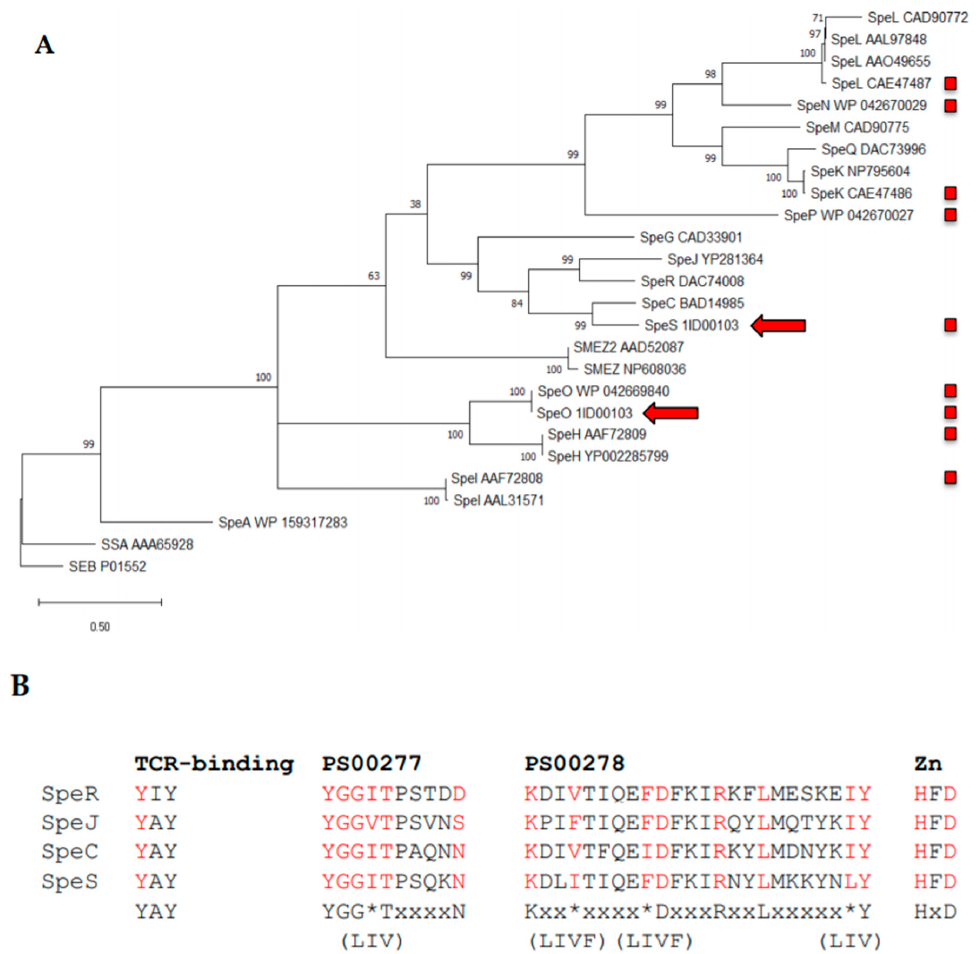
Figure 1. Similarity of the novel superantigen SpeS to known superantigens. ( A ) The amino acid sequences of representatives of the 16 known streptococcal superantigens, SpeS and the staphylococcal superantigen SEB were obtained. Nomenclature has been standardized in accordance with Commons et al., 2014 [13]. The signal sequences were identified using SignalP [21] and removed. The remaining predicted amino acid sequences were utilized to generate a maximum likelihood tree in MEGA X [22], which was rooted to SEB. The percentage of trees in which the associated taxa clustered together is shown next to the branches. The tree is drawn to scale, with branch lengths measured in the number of substitutions per site. The red arrows indicate the location of the SpeO and SpeS sequences encoded within the Sz 1ID00103 genome. Red boxes indicate superantigens encoded by S. equi or S. zooepidemicus . ( B ) Identification of signature domains found in superantigens. The amino acid sequence of SpeS was compared to the closest relatives SpeC, SpeJ and SpeR to identify motifs typically found in superantigens. The T cell receptor ß-binding motif YAY of SpeC [19,20], the consensus sequence Y-G-G-(LIV)-T-x 4 -N and K-x 2 -(LIVF)-x 4 -(LIVF)-D-x 3 -R-x 2 -L-x 5 -(LIV)-Y of the superantigen Prosite domains PS00277 and PS00278, respectively, and the zinc binding domain, HxD, were fully conserved in SpeS. Consensus matching residues are indicated in red. * represents one of the three or four possible amino acids indicated in brackets on the line directly below.